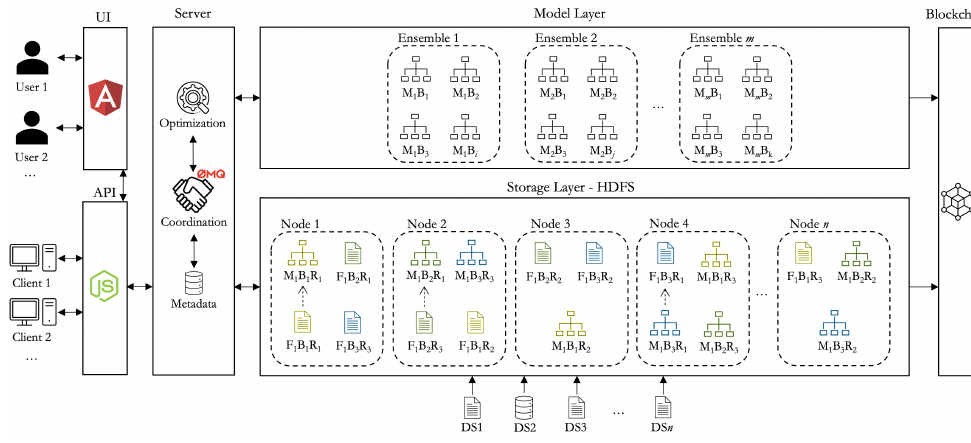
Figure 1. General overview of the architecture of